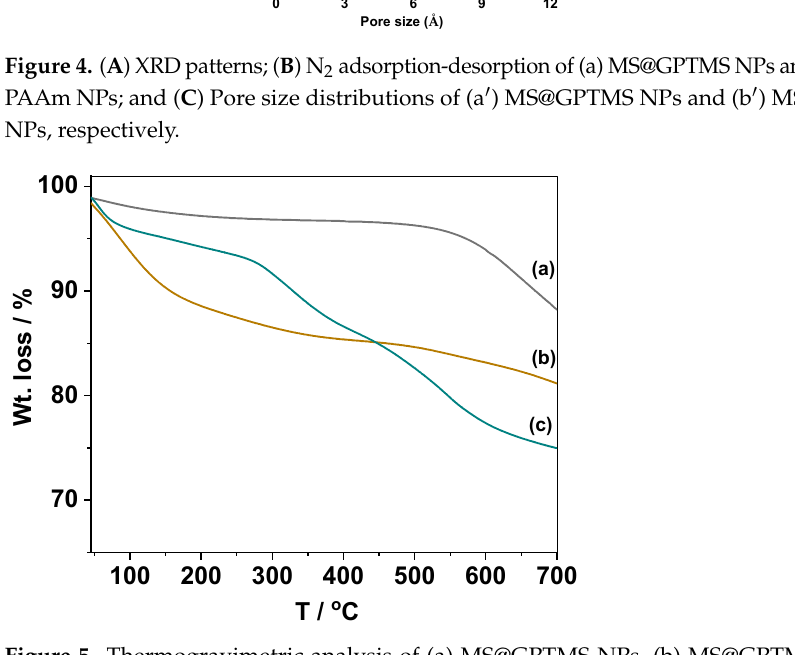
Figure 5. Thermogravimetric analysis of (a) MS@GPTMS NPs, (b) MS@GPTMS-CTAB NPs, and (c)